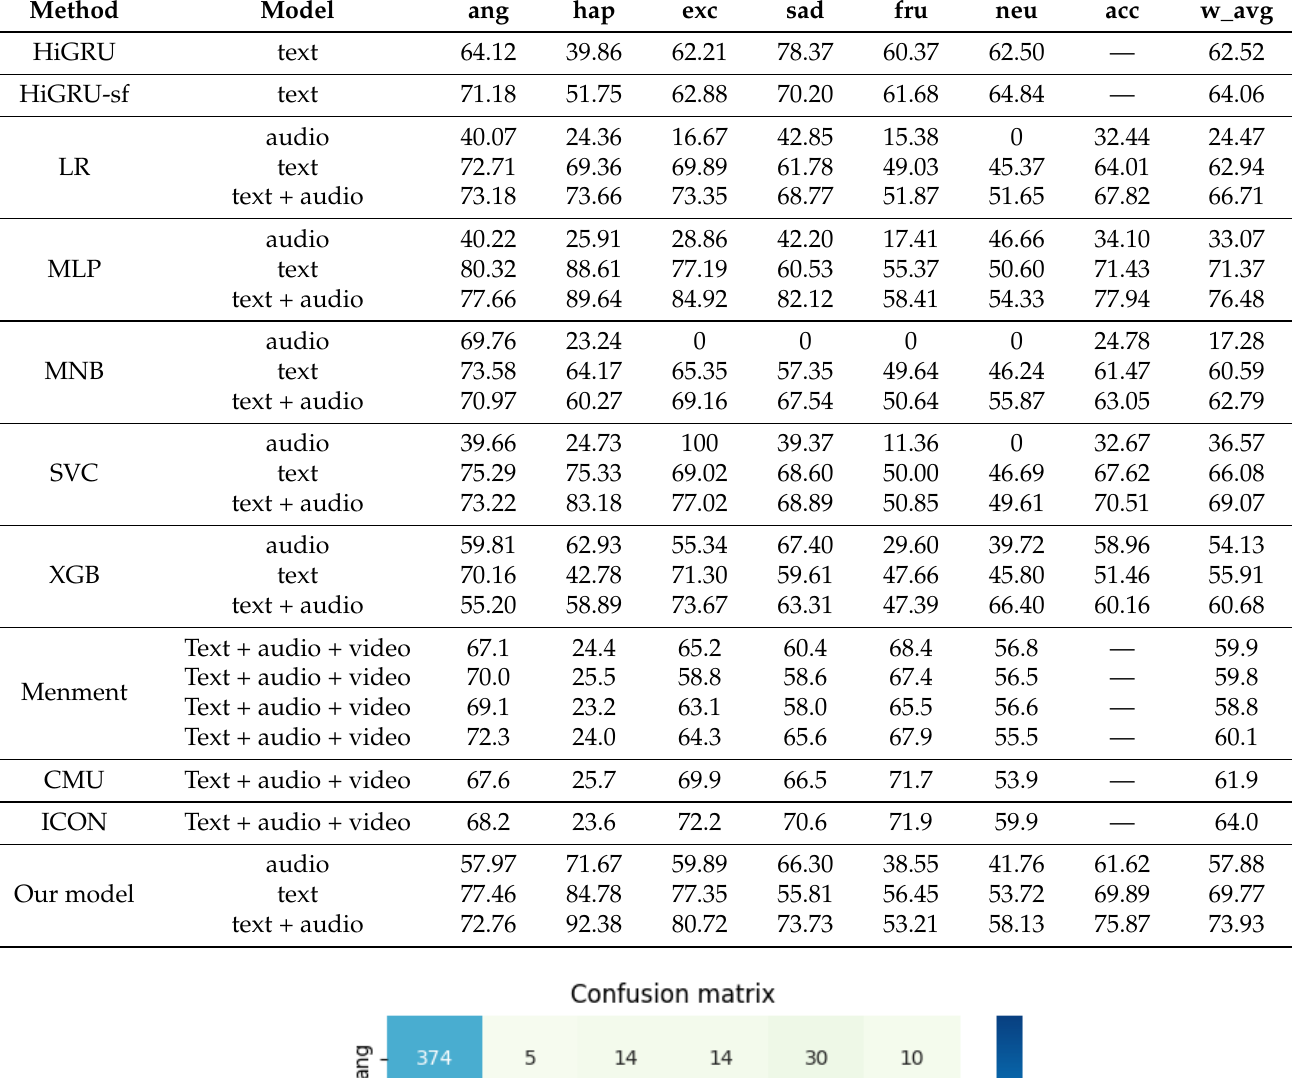
Table 3. IEMOCAP dataset analysis result table.